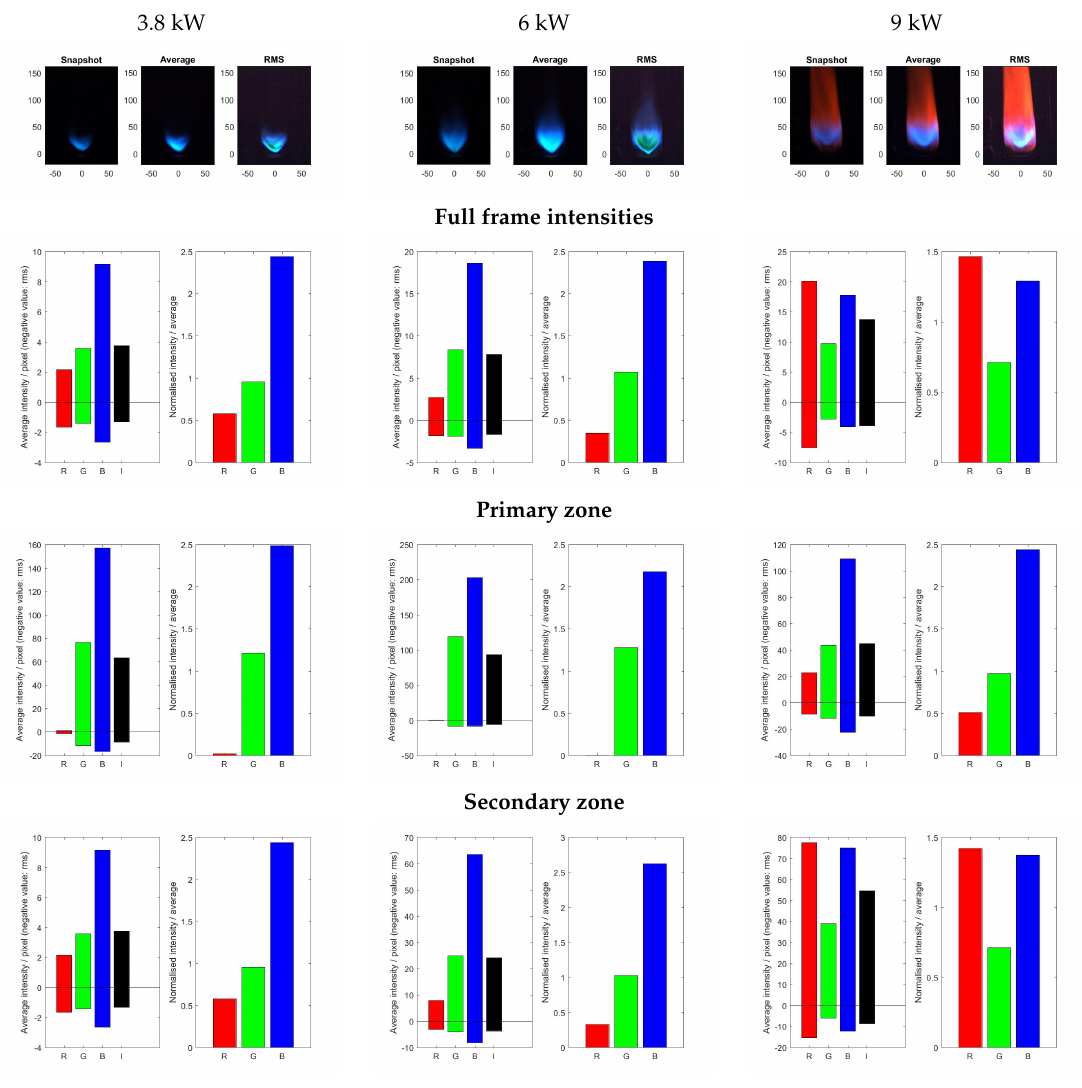
Figure 16. Red, green, blue (RGB) analysis of the flame at three thermal power settings using photography, with details of the primary and secondary zones. Legend: the colour components are explicit, and the black bars represent the gray level component